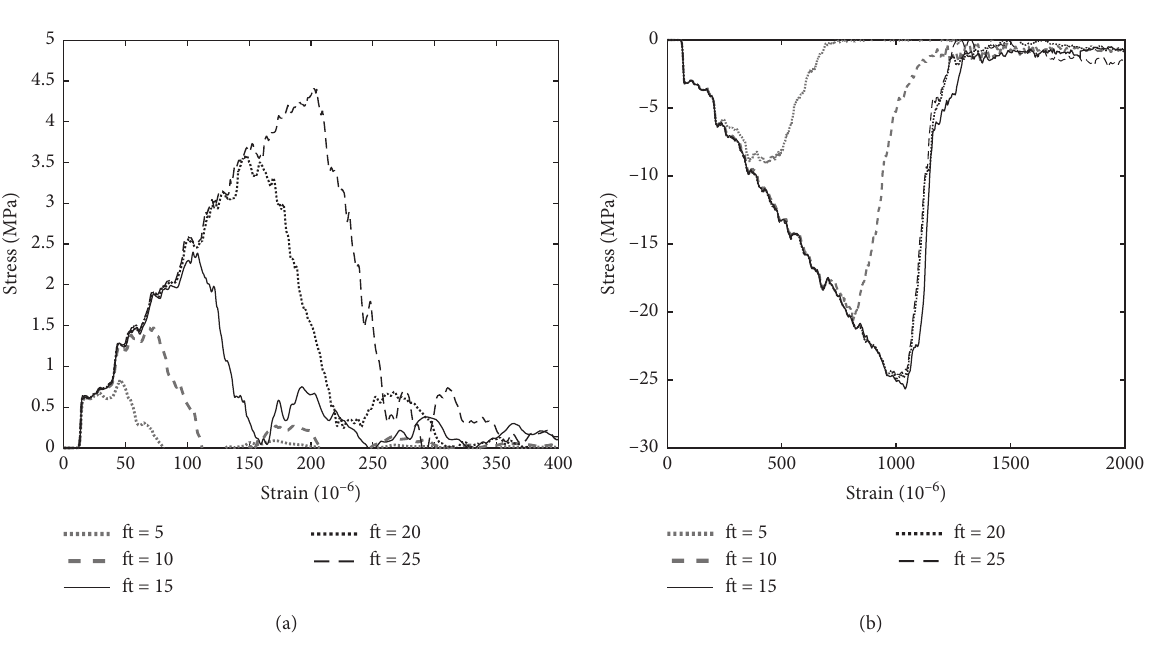
Figure 13: Parametric study of the parameter f